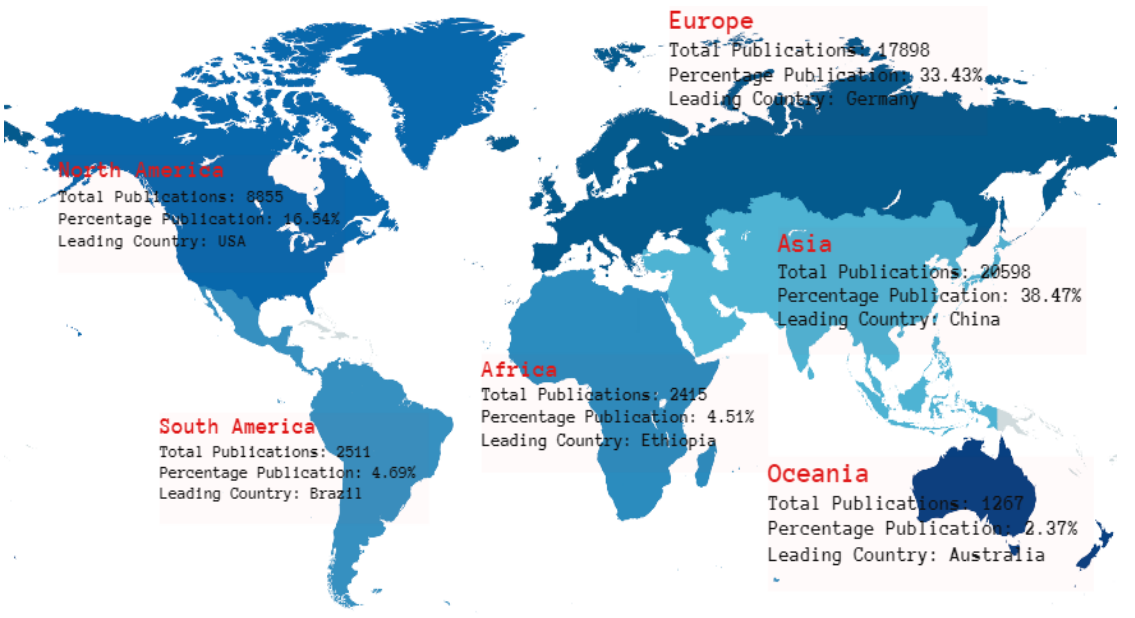
Figure 9. Continent-wise research contributions for the years (2019–2021).